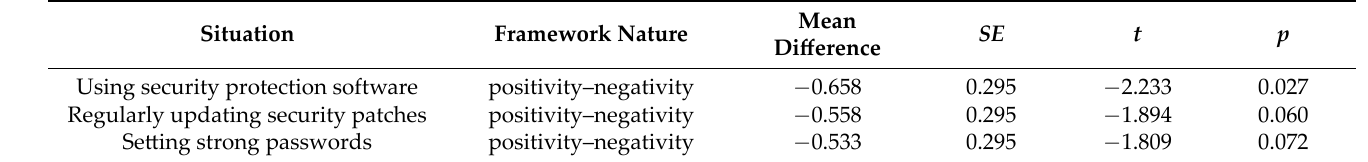
Table 5. Simple Effects (Situation and Framework